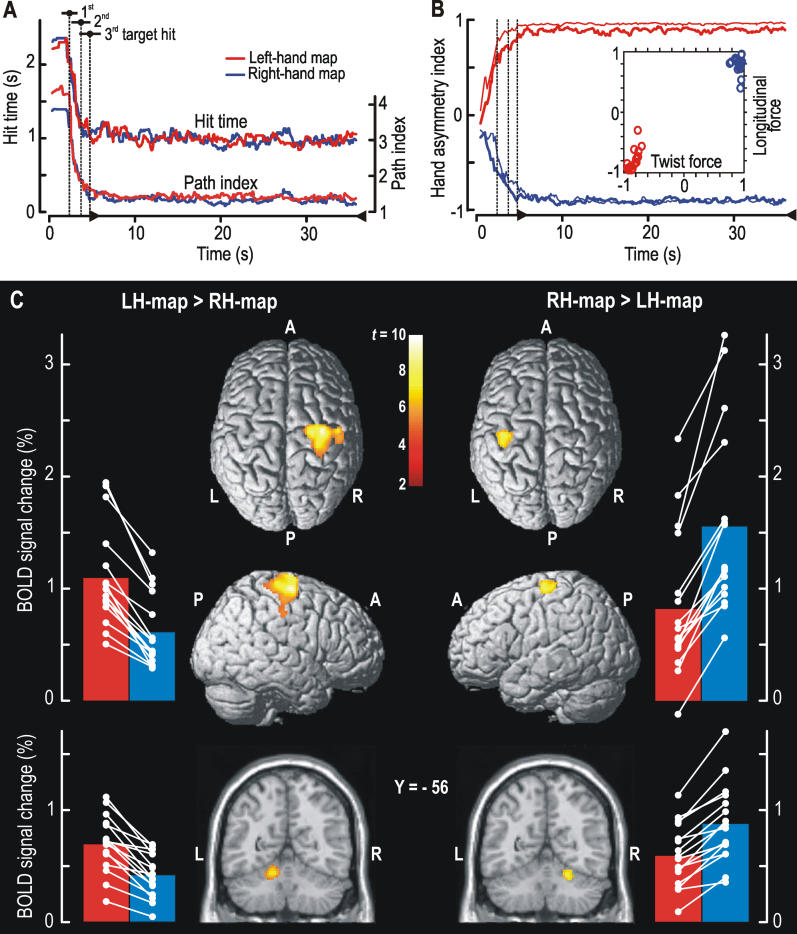
Brain Activity and Performance during Runs in the Scanner Averaged across Participants(A) Median hit time and path index as a function of time; arrowheads delimit the period used in fMRI analyses. Vertical lines indicate mean time for 1st, 2nd, and 3rd target hit with both maps (horizontal bar gives ± 1 SD).(B) Median hand-asymmetry index for horizontal (thick lines) and twist (thin lines) forces computed for a ±1-s sliding time window. Inset shows for each participant median indices for the delimited period plotted against each other.(C) Areas with stronger BOLD responses for left-hand map (LH-map > RH-map) and right-hand map (RH-map > LH-map). The surface rendered diagrams, based on single-participant standardized brain template in SPM2, do not indicate precisely locations of cortical activations since they may extend deep into sulci. See further
Table 1. R, right; L, left; A, anterior; P, posterior.
Top and bottom histograms give the percent BOLD signal change relative to mean of session as a function of mapping rule within the cortical and cerebellar cluster, respectively, for each contrast. Height of bars gives data averaged across participants and symbols joined by lines represent data from an individual participants.